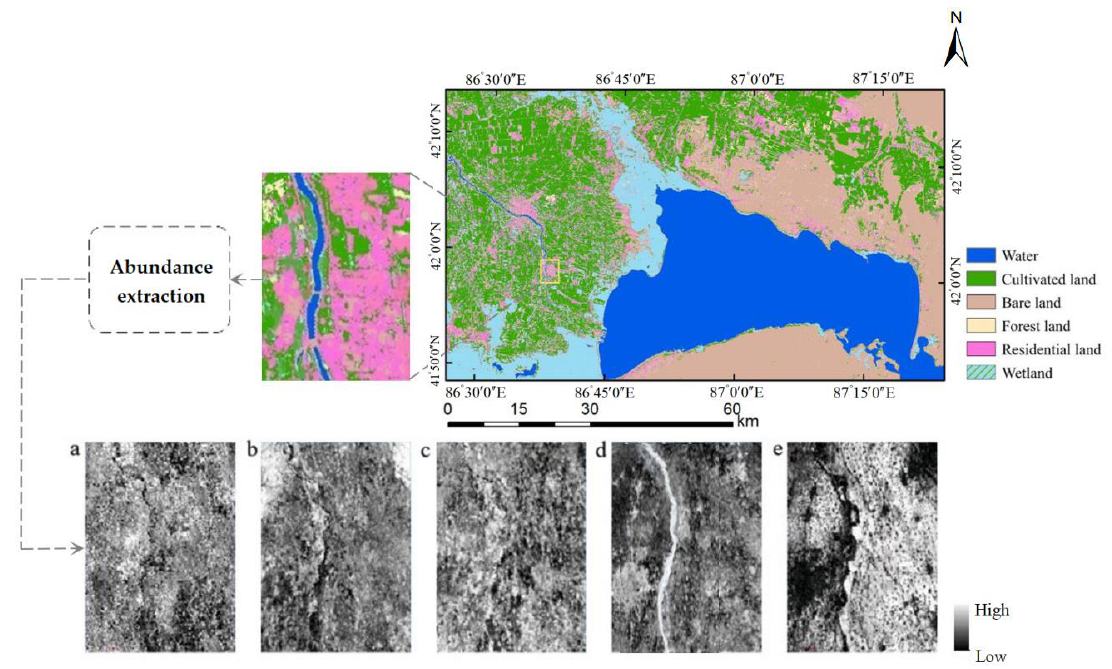
Figure 4. Fraction image of typical land cover types. ( a ) Cultivated land fraction, ( b ) forest land fraction, ( c ) bare land fraction, ( d ) water fraction, ( e ) residential land fraction.